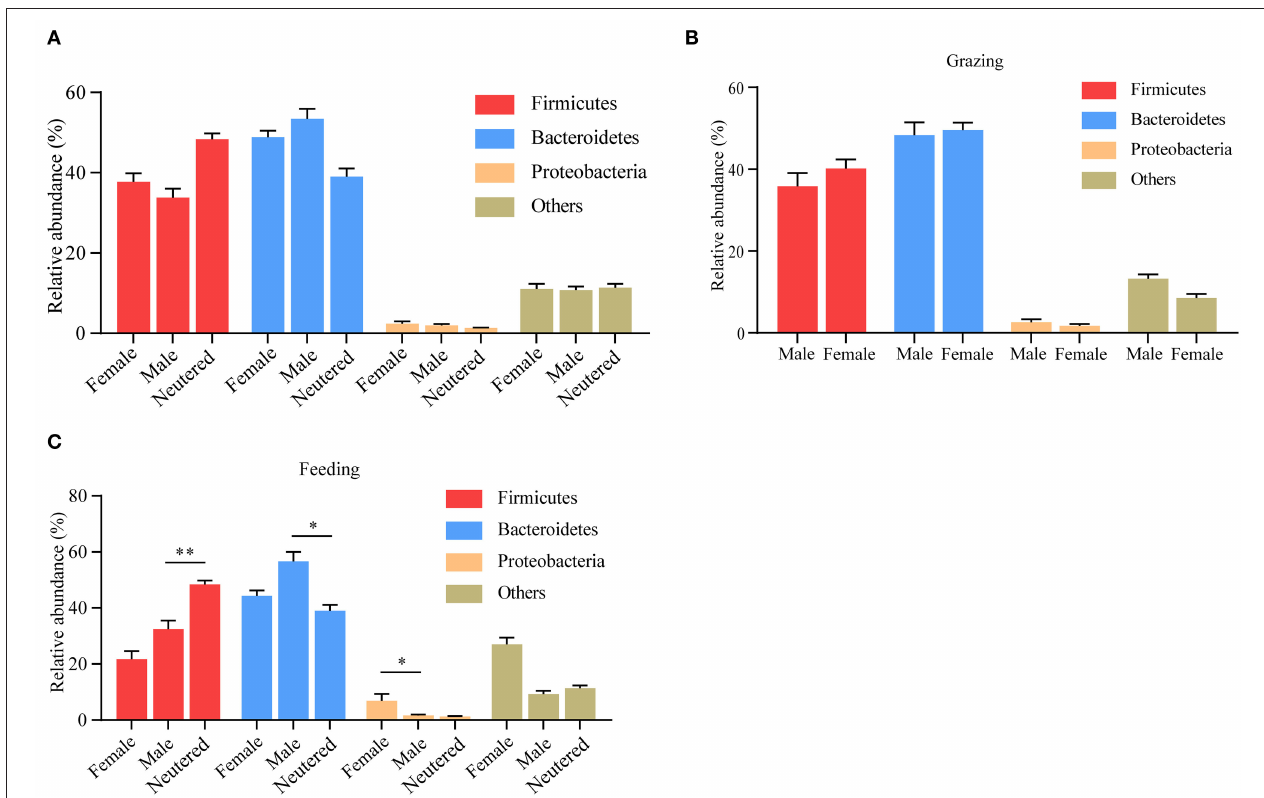
FIGURE 6 | Influence of sex on yak rumen microbiota. (A) The relative abundance of phylum level was compared between male, female, and neutered yaks, irrespective of the method of yak husbandry. (B) The difference in each phylum when yak kept grazing. (C) The difference in each phylum when yak kept indoors. The data were expressed as mean ± SEM. The Mann–Whitney test was applied for intragroup comparison, whereas the Kruskal–Wallis test with post hoc Dunn’s test was used for intergroup comparison. * p < 0.05, ** p <